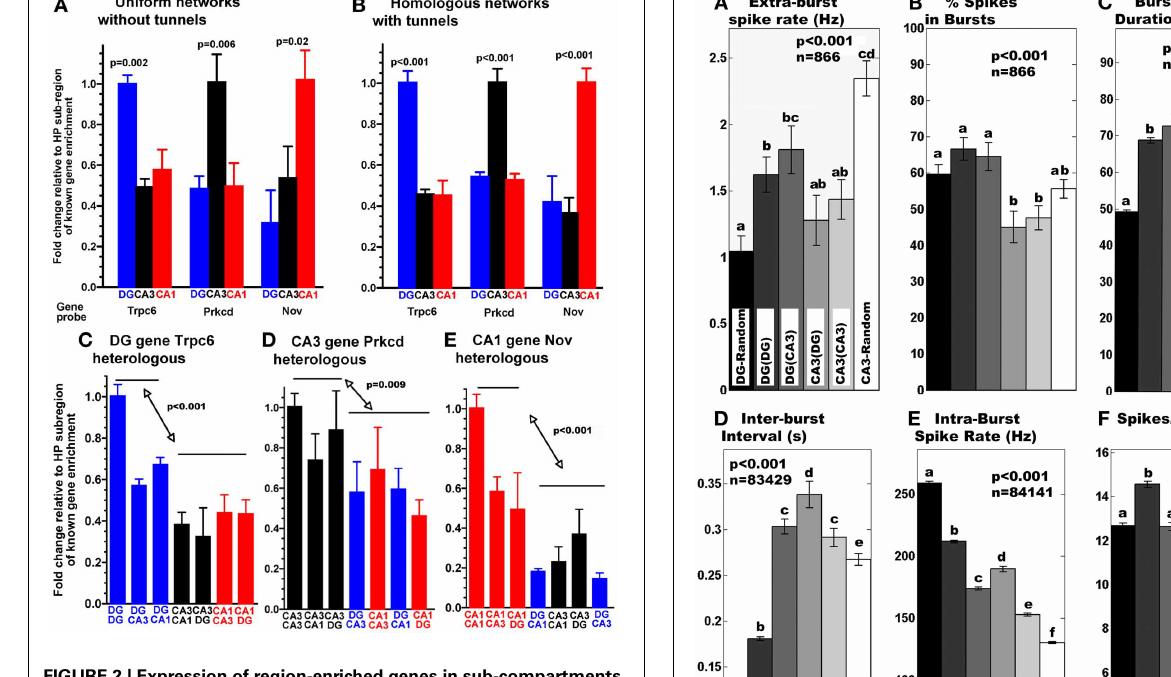
FIGURE 2 | Expression of region-enriched genes in sub-compartments phenocopies selective expression in the adult hippocampus as measured by qPCR. Specific genes probed for expression after 3 weeks in (A) the indicated homogeneous random cultures without tunnel devices. Note enrichment of Trpc6 in the DG cultures, Prkcd in the CA3 cultures, and Nov in the CA1 cultures. (B) The same hippocampal subregions plated into each of two compartments of the tunnel device. Note same enrichment profile in the tunnel device as in the random cultures. (C) Enriched expression of the DG gene Trpc6 whenever DG neurons are present in heterologous combinations of hippocampal subregions cultured between tunnels, normalized to DG cultured on both sides of the tunnels. (D) Enriched expression of the CA3 gene Prkcd when CA3 neurons are present in heterologous combinations of hippocampal sub-regions cultured between tunnels, normalized to CA3 cultured on both sides of the tunnels. (E) Enriched expression of the CA1 gene Nov when CA1 neurons are present in heterologous combinations of hippocampal sub-regions cultured between tunnels, normalized to CA1 cultured on both sides of the tunnels. Note the similar expression of each region-specific gene to neurons of that region in combination with heterologous regions, while the other 4 combinations without this region express lower levels of this marker mRNA ( n = 3 separate cultures).